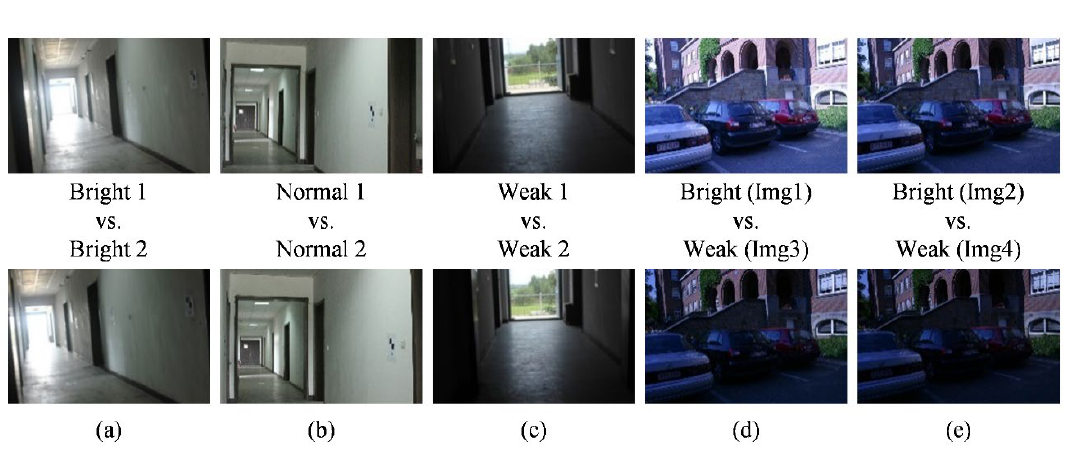
Figure 5. The experimental images from the datasets along with their description: ( a ) the first image pair; ( b ) the second image pair; ( c ) the third image pair; ( d ) the fourth image pair; ( e ) the fifth image pair.